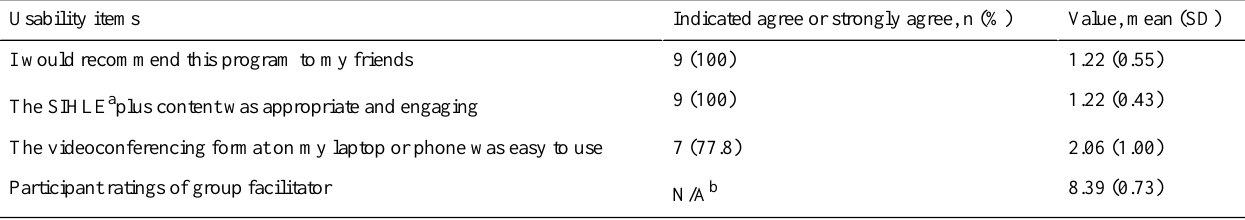
Table 2. Descriptive statistics of usability